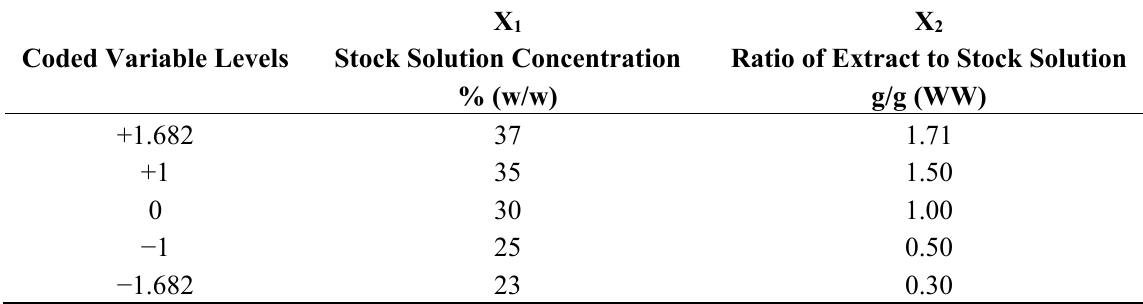
Table 1. The coded and uncoded levels for the two independent variables. Coded Variable